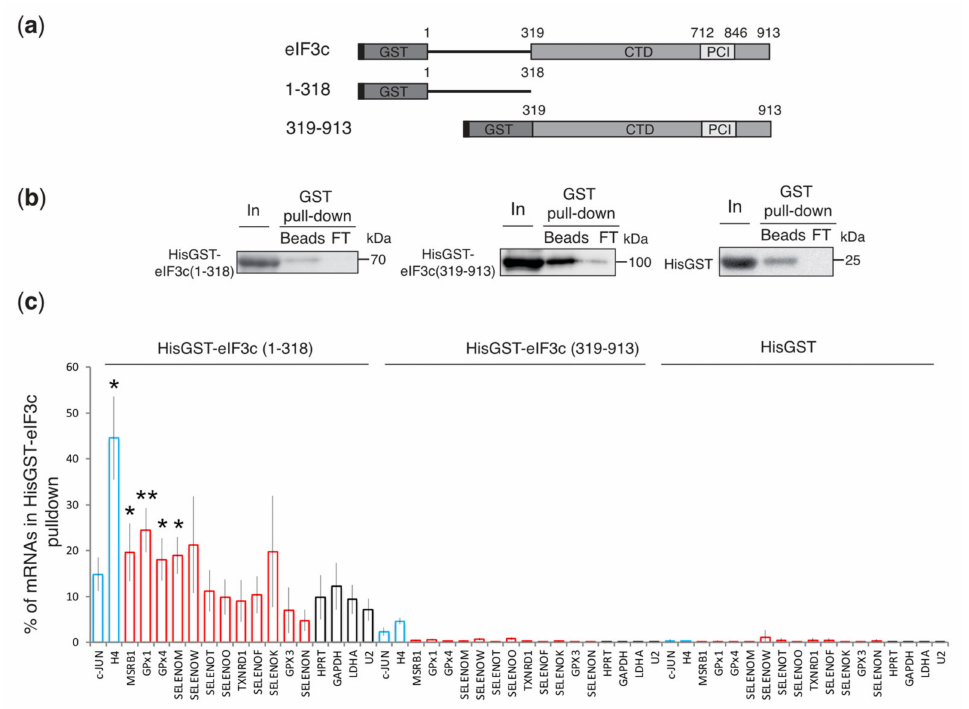
Figure 3. The N-terminal domain of eIF3c interacts with selenoprotein mRNAs. ( a ) Schematic representation of eIF3c (1-913) and truncated recombinant eIF3c fused to hexa-histidine and glu- tathione S-transferase (HisGST). eIF3c contains a PCI (Proteasome, COP9/signalosome, eIF3) motif (712-846) in the C-terminal region (CTD). eIF3c (1-318) corresponds to the N-terminal domain and eIF3c (319-913) to the CTD. ( b ) GST pull-down experiments were performed using the HisGST proteins